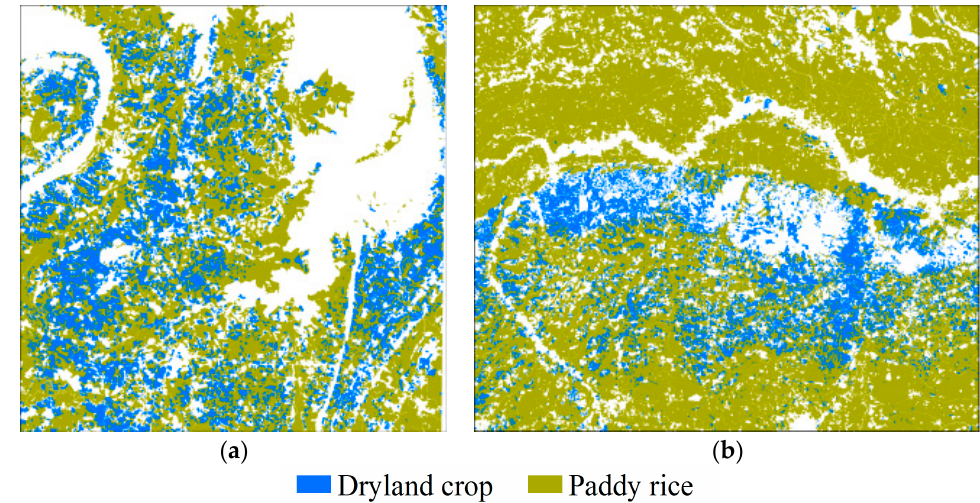
Figure 10. Cropland classification result from the original DTW distance and OLWDTW distance with the optimal enhance factor σ : ( a ) is the validation classification map of cropland in test site 1; ( b ) is the validation classification map of cropland in test site 2.